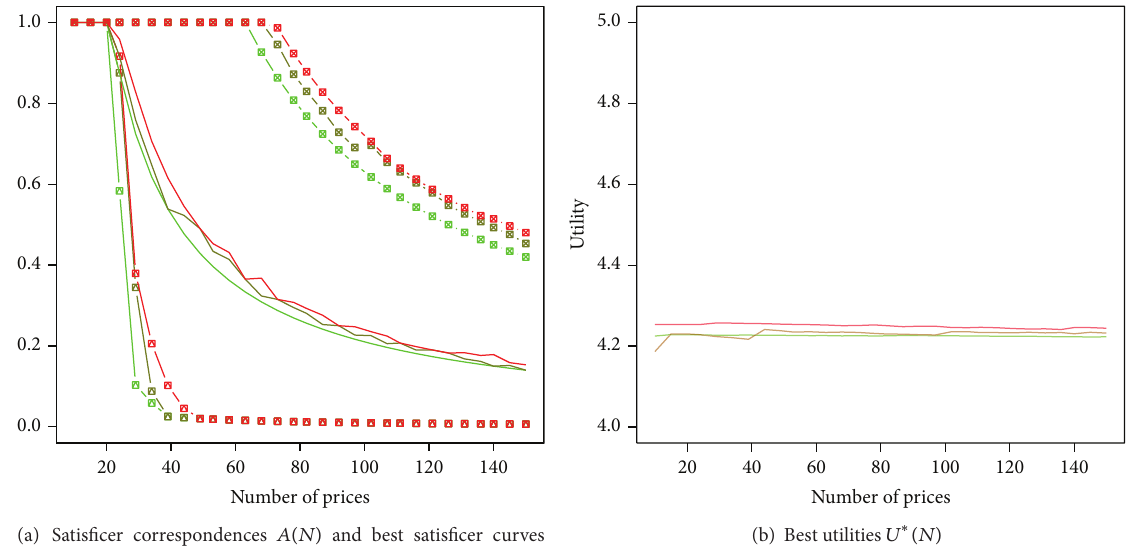
Figure 10: Analysis of satisficing behavior for dispersion and mean preserving split-normal distributions as left dispersion 𝜎 1 increases. Color of graphs shifts from green to red as 𝜎 1 increases (see Table 5).